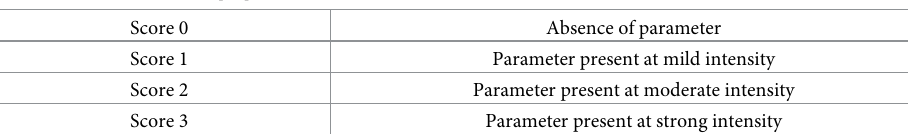
Table 1. Parameter scores